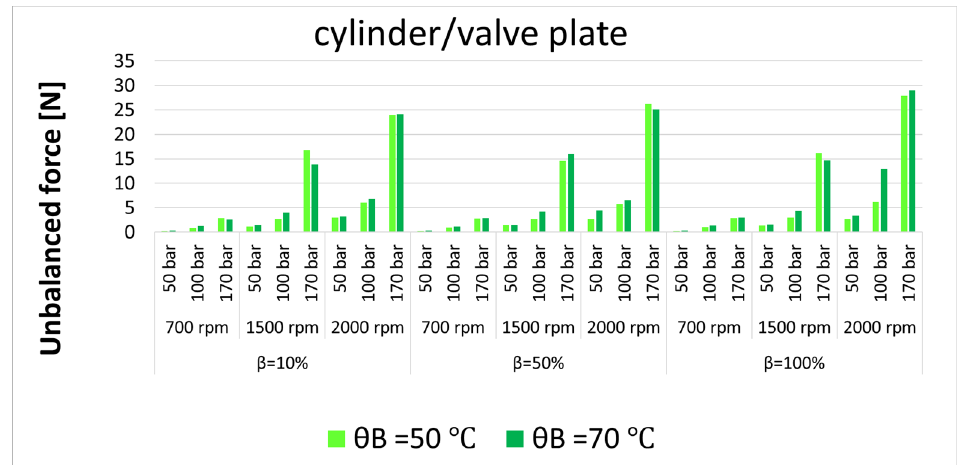
Figure 30. Unbalanced forces in the cylinder/valve plate interfaces at different operating conditions.